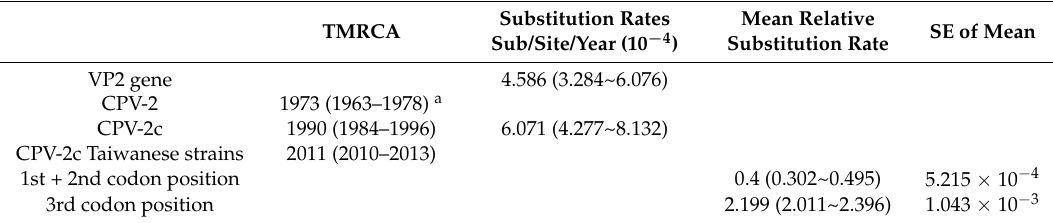
Table 2. Mean Relative Evolutionary Rates for Codon Positions and TMRCA in VP2 gene.